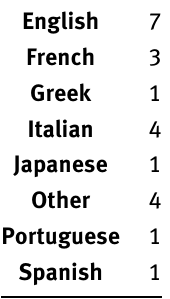
Table 3: Native language of participants.